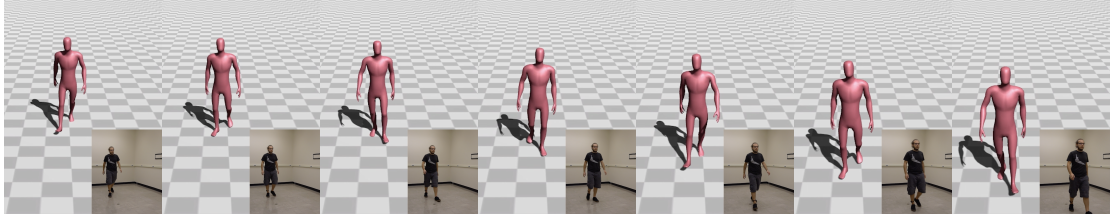
Figure 8. Example of walking motion reconstructed with the proposed